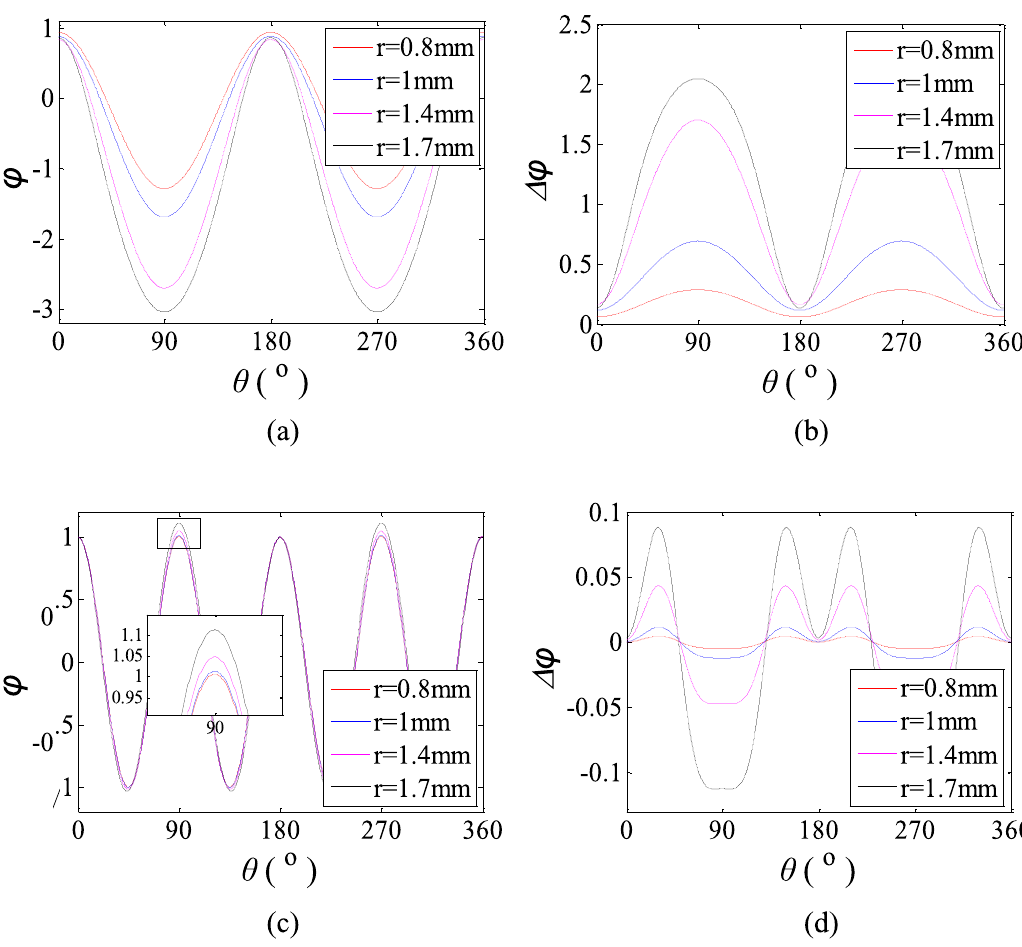
Fig. 5. Vibration modes for different radius r. (a) Mode 1 (b) D f = f e (cid:1) f 3 for mode 1 (c) mode 2 (d) D f = f e (cid:1) f 3 for mode 2. Table 13. Comparison of calculated and simulated natural